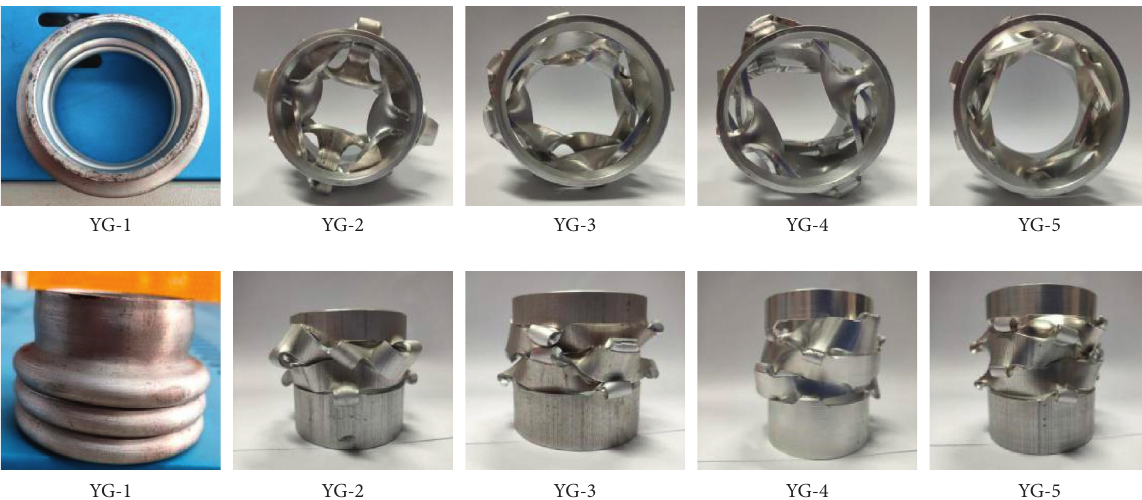
Figure 9: Deformation morphology of components in the crushing buckling